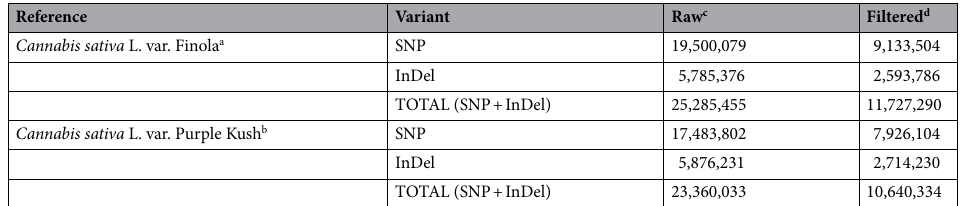
Table 2. Number of short variants called using extreme-phenotype bulk pools when mapped to Finola and Purple Kush Cannabis reference sequences. SNP single nucleotide polymorphism, InDel small insertion- deletion. a Concatenated Cannabis sativa L. var. Finola reference sequence [GenBank: ASM341772v2]. b Concatenated Cannabis sativa L. var. Purple Kush reference sequence [GenBank: ASM23057v2]. c Raw unfiltered variants called using GATK HaplotypeCaller. d Hard filtered biallelic variants with depth of coverage (DP) ≥ 15 × and genotype quality (GQ) ≥ 20 that had genotype calls for both chemotypic pools at the variant